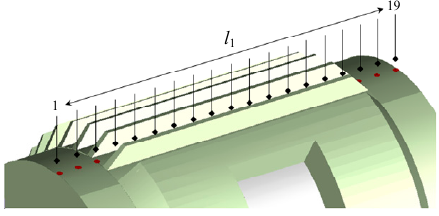
Figure 9. Air velocity measured positions on the motor frame.